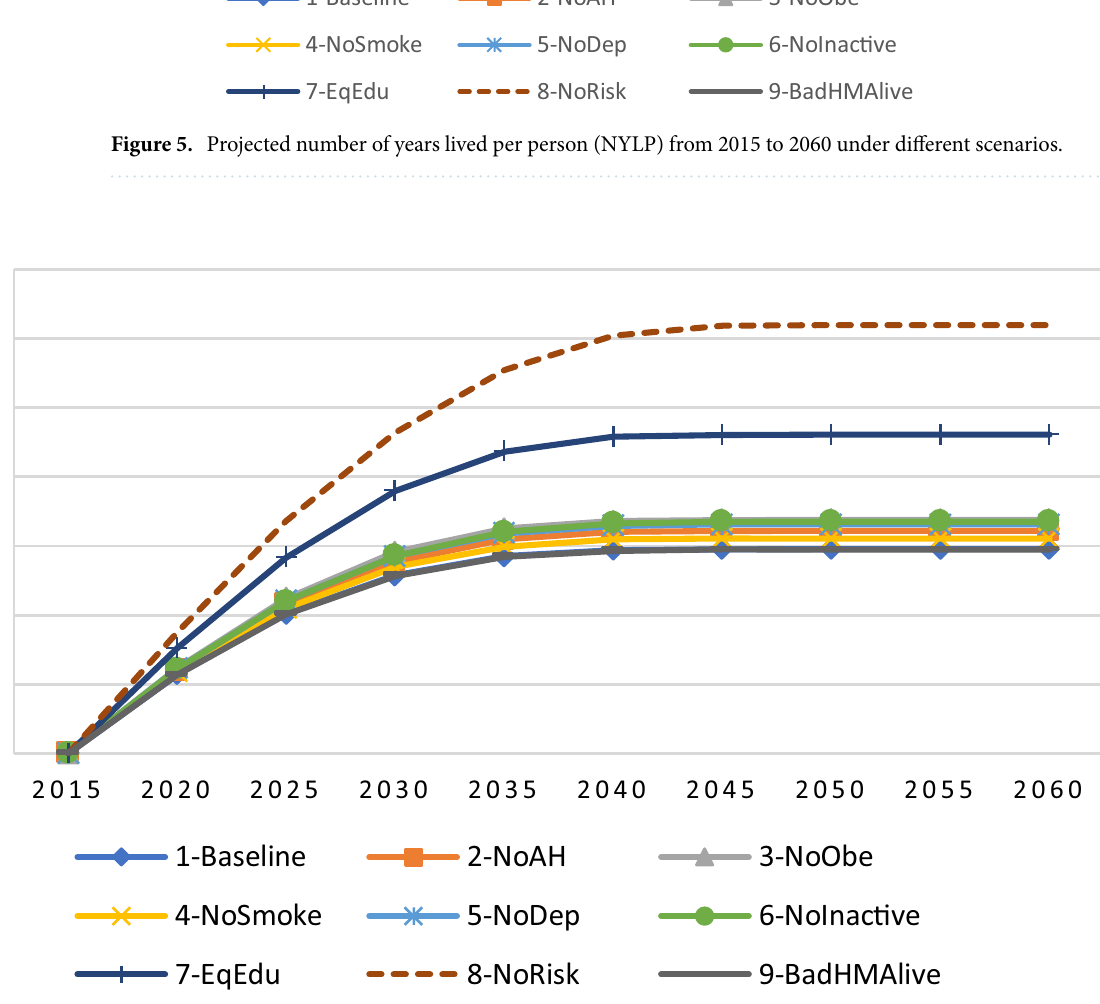
Figure 6. Projected Number of years lived per person (NYLP) in good health ( HM ≥ 60) from 2015 to 2060 under different